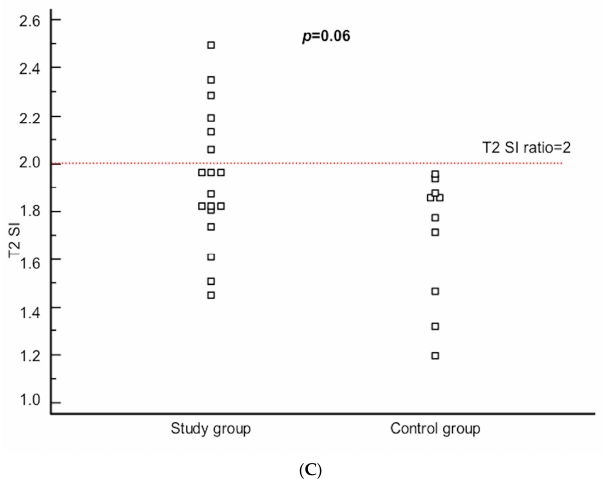
Figure 1. ( A ) Distribution plot comparing T1 pre-contrast times in patients with RA and controls. ( B ) Distribution plot comparing T2 times in patients with RA and controls. ( C ) Distribution plot comparing T2 SI ratio in patients with RA and controls. Cut-off points for normal values are marked with a dotted red lines.